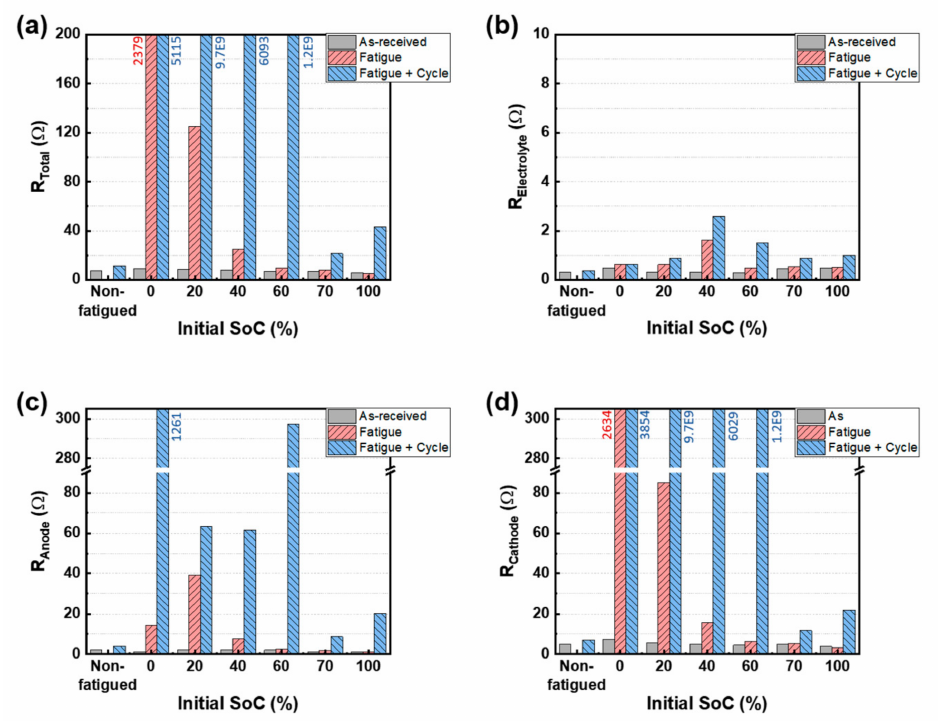
Figure 6. ( a ) total resistance (R Total ), ( b ) electrolyte resistance (R E ), ( c ) anode resistance (R A ), and ( d ) cathode resistance (R C ) for the different SoC cells under the conditions of as-received, after the fatigue test, and after the fatigue and cycling